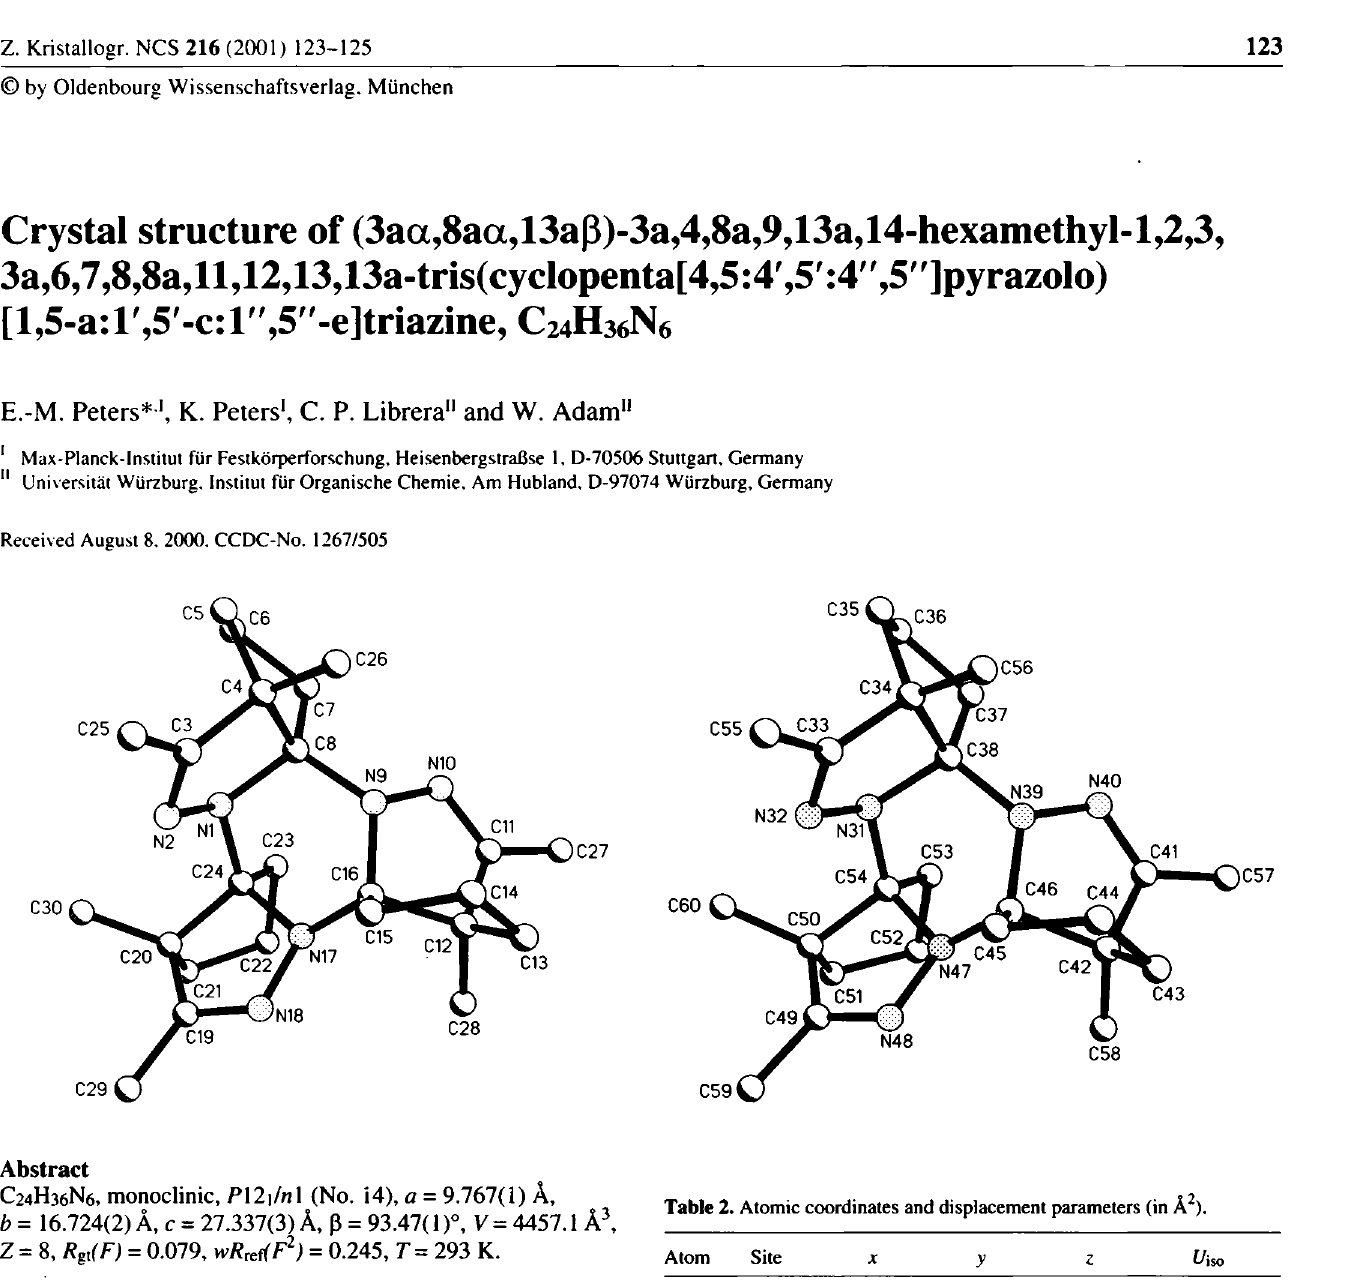
Table 2. Atomic coordinates and displacement parameters (in A ). C24H36N6, monoclinic, P\2\!n\